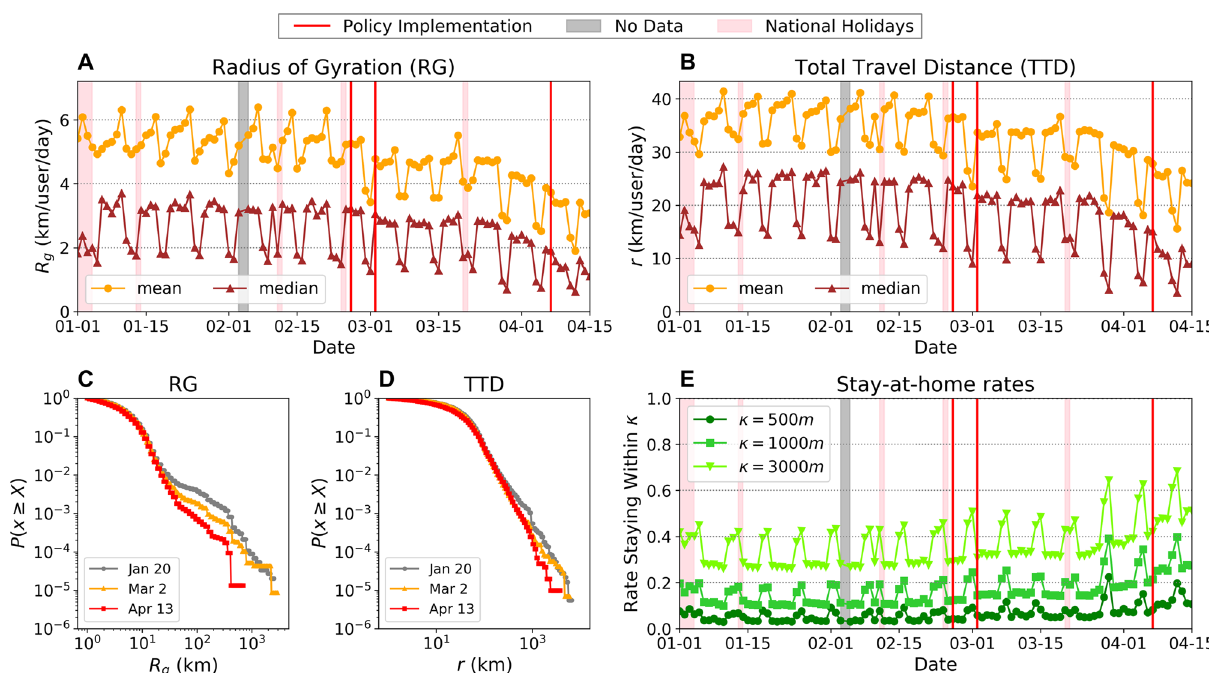
Figure 2. Changes in individual mobility patterns. Temporal transition of mean and median radius of gyration ( A ), total travel distance per day ( B ) and their complementary cumulative distribution functions ( C ), ( D ), respectively. Panel ( E ) shows the rate of staying κ meters within estimated home locations. Red vertical lines in panels ( A , B , E ) show the timings of NPIs (remote work request, public school closure, and state of emergency,